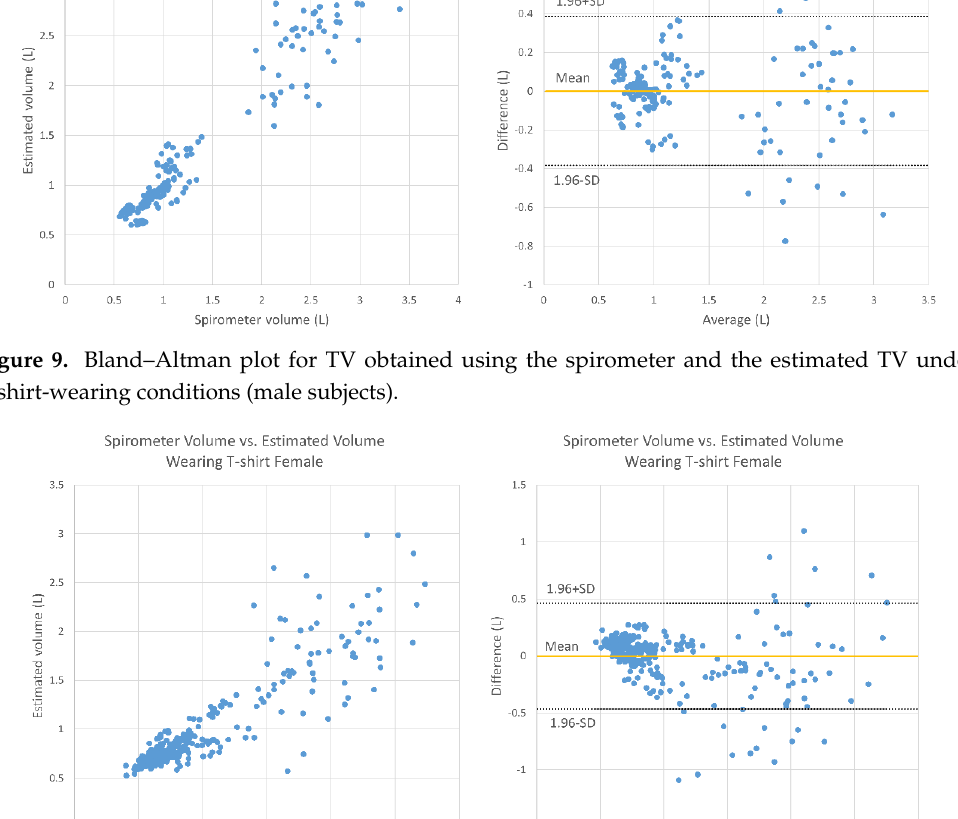
Figure 10. Bland–Altman plot for TV obtained using the spirometer and the estimated TV under T- shirt-wearing conditions (female subjects).